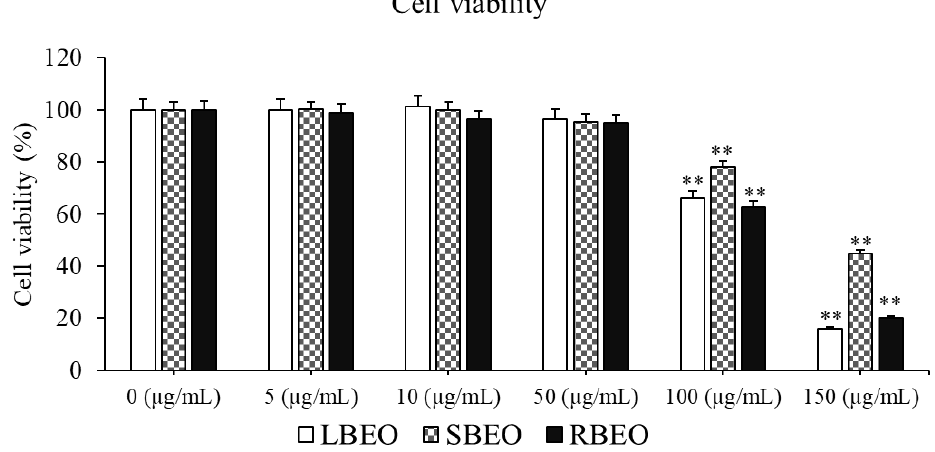
Figure 2. Effect of BEOs on the viability of RAW 264.7 macrophages. Various concentrations of LBEO, SBEO, and RBEO (0, 5, 10, 50, 100, and 150 µ g/mL) were added to macrophage cell cultures for 24 h at 37 ◦ C, the cell viability was then assessed using the CCK-8 kit. Data from three independent experiments were used to calculate mean values and standard deviation. ** p < 0.001 vs. negative control (0 µ g/mL EOs).